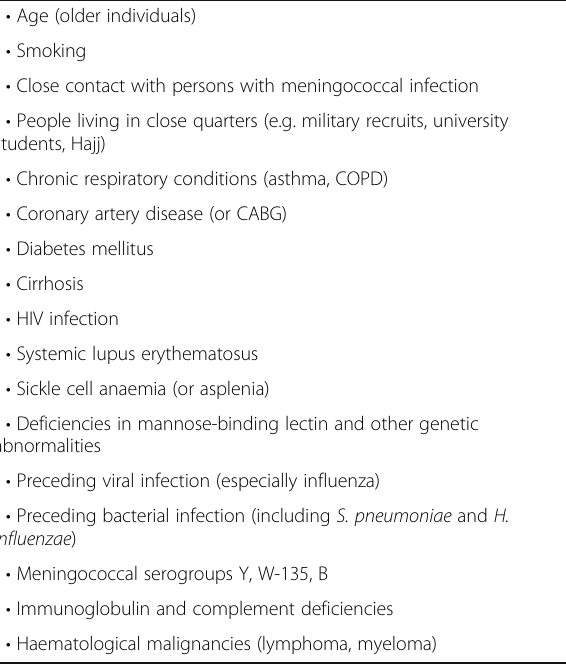
Table 1 Possible risk factors for invasive meningococcal disease and/or meningococcal